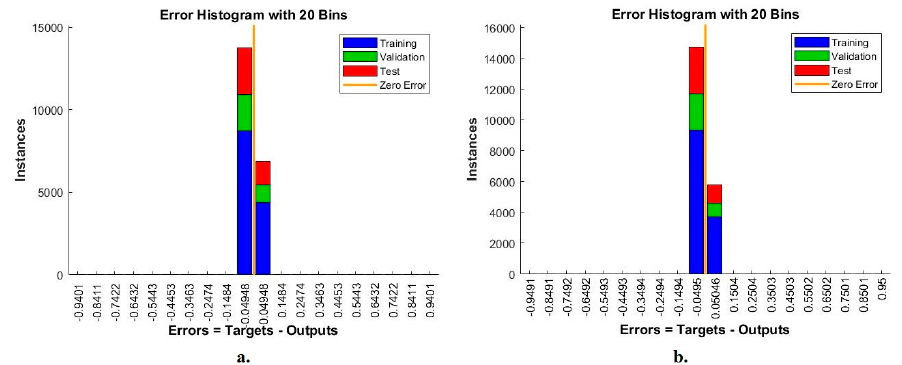
Figure 11. The error histogram for diagnosing the X ‐ ray images of pneumonia and tuberculosis us ‐ ing the ANN with features ( a ). VGG16 and LDG; ( b ). ResNet18 and